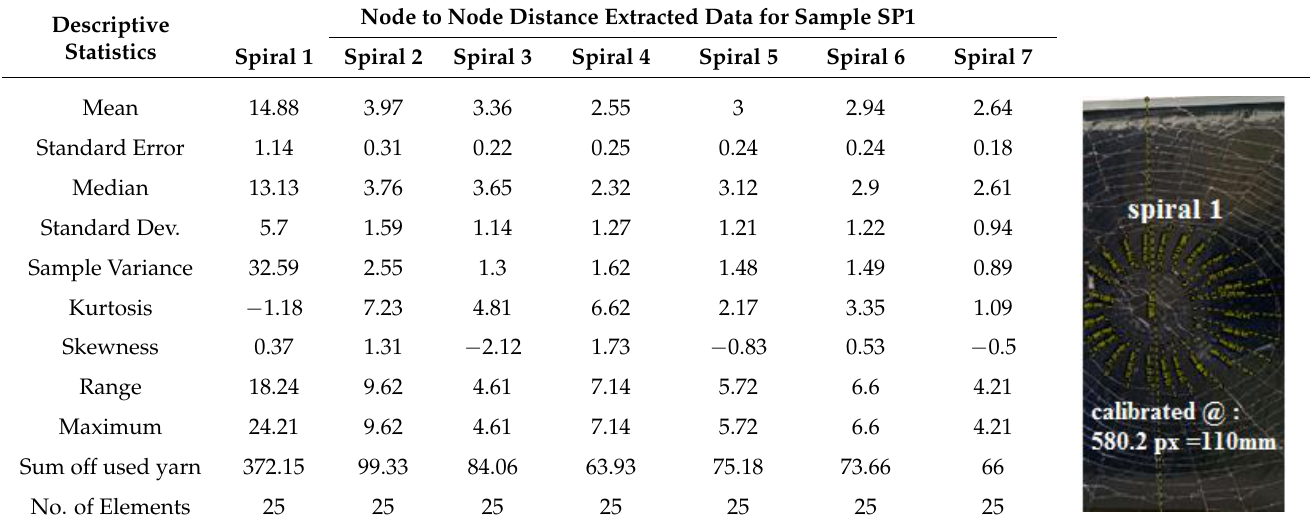
Table 2. Summary of extracted data for a spiral distance of sample SP1.